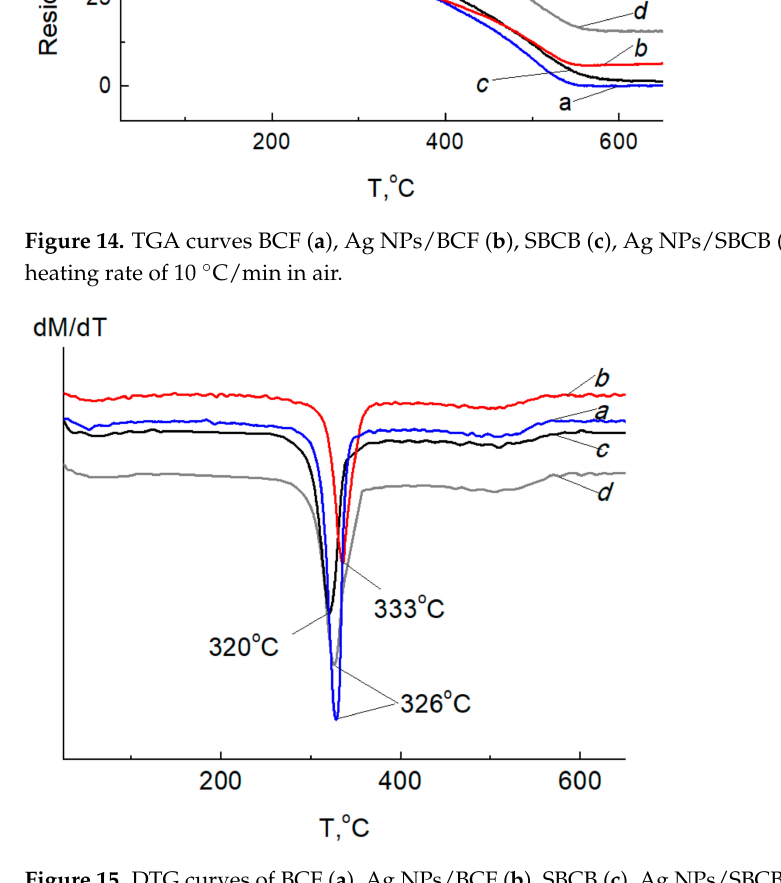
Figure 15. DTG curves of BCF ( a ), Ag NPs/BCF ( b ), SBCB ( c ), Ag NPs/SBCB ( d ) at a heating rate of 10 ◦ C/min in